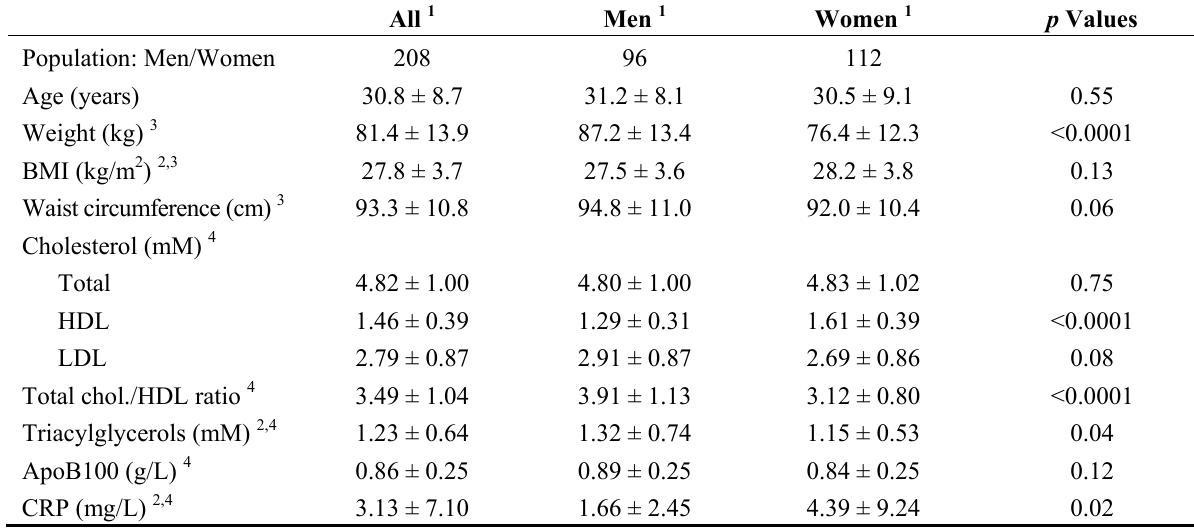
Table 2. General characteristics of the study sample before n -3 PUFA